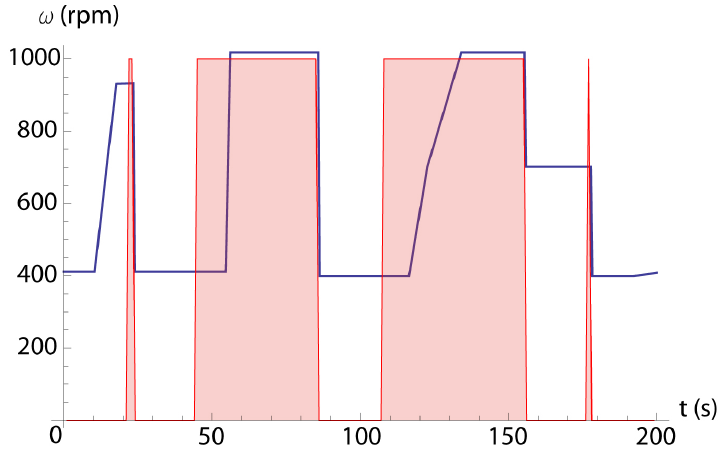
Figure 13: Vacuum pump engagement condition during urban cycle.